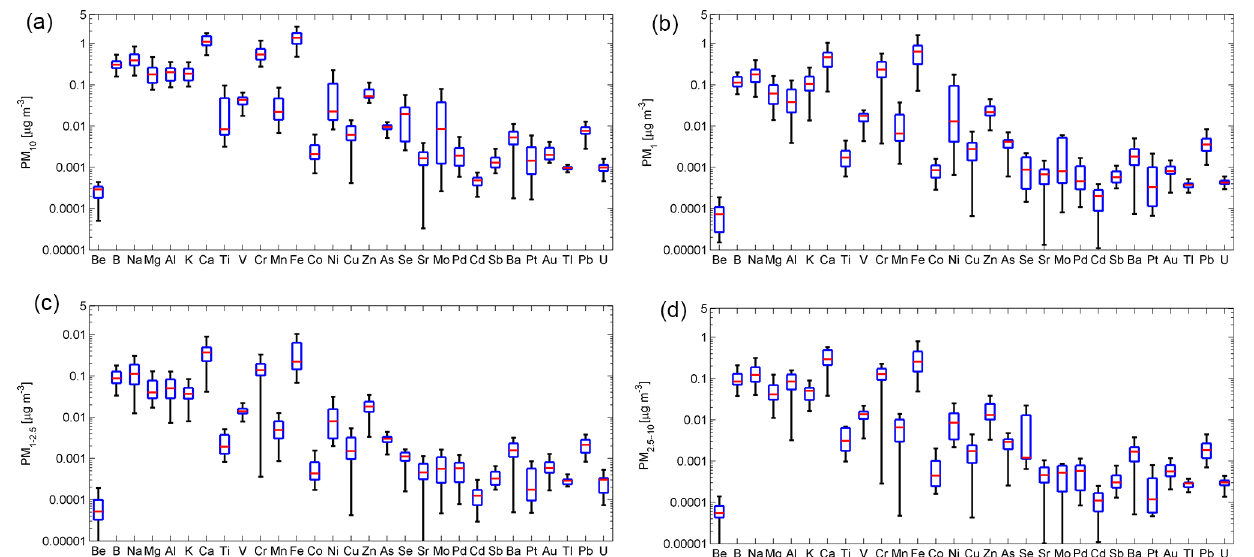
Figure 2. Box-and-whisker plots of trace metal concentrations in the (a) PM 10 (sum of trace metal concentrations in the three size fractions), (b) PM 1 , (c) PM 1–2 . 5 and (d) PM 2 . 5–10 size fractions. The red line indicates the median concentrations, the blue rectangle of the box plot represents the 25th and 75th percentiles, and the whiskers indicate ± 2.7 times the standard deviation.